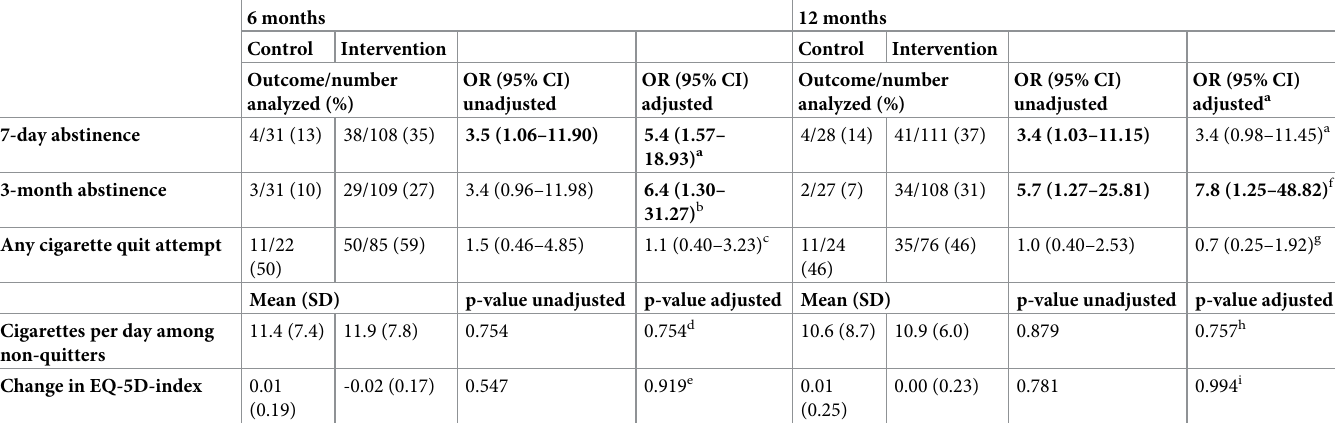
based questionnaires could have increased the response rate in this target group [30]. Difficulties with recruiting and retaining PHC centers and patients could also be explained by high staff turnover, workload, and organizational changes in PHC as these were the main barriers for PHC centers to engage in the study. PHC centers with one staff member responsi- ble for tobacco cessation were particularly vulnerable to this. Lone responsibility to work with tobacco cessation has previously been emphasized as a barrier to continuity, negatively affecting access to cessation treatment [9, 15]. It also resulted in a smaller sample size and higher level of uncertainty in the results than expected. This is reflected in the wide confidence intervals for the odds ratios reported in the results. In addition, large differences in cluster sizes (1–29 obser- vations per cluster at follow-up) may have introduced uncertainty in the cluster analysis. The results from the primary analysis were confirmed in non-hierarchical models without any Table 3. Treatment outcomes at 6 and 12 months